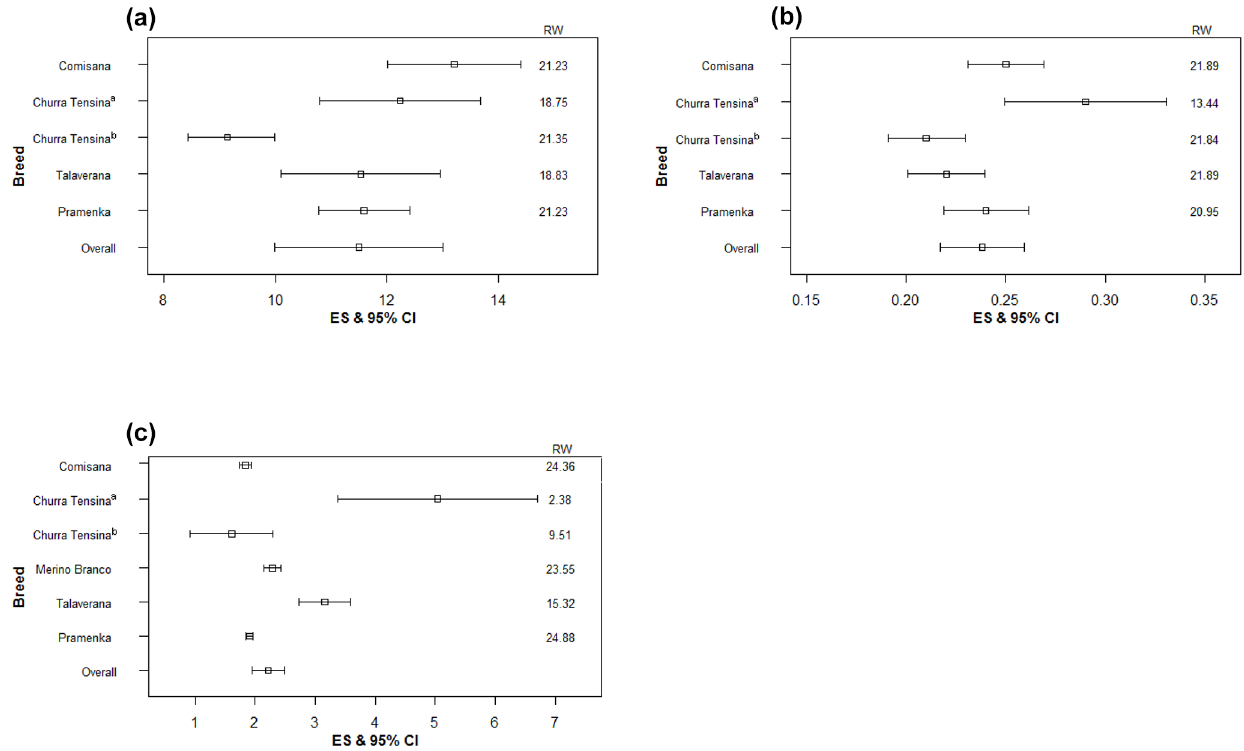
Figure 3. Meta-analysis of PUFA (a) , PUFA / SFA ratio (b) and n-6 / n-3 ratio (c) . Different superscript letters ( a,b ) indicate lambs of the same breed included in different studies; ES: effect size; CI: confidence interval; RW: relative weight of the study; Overall: overall pooled